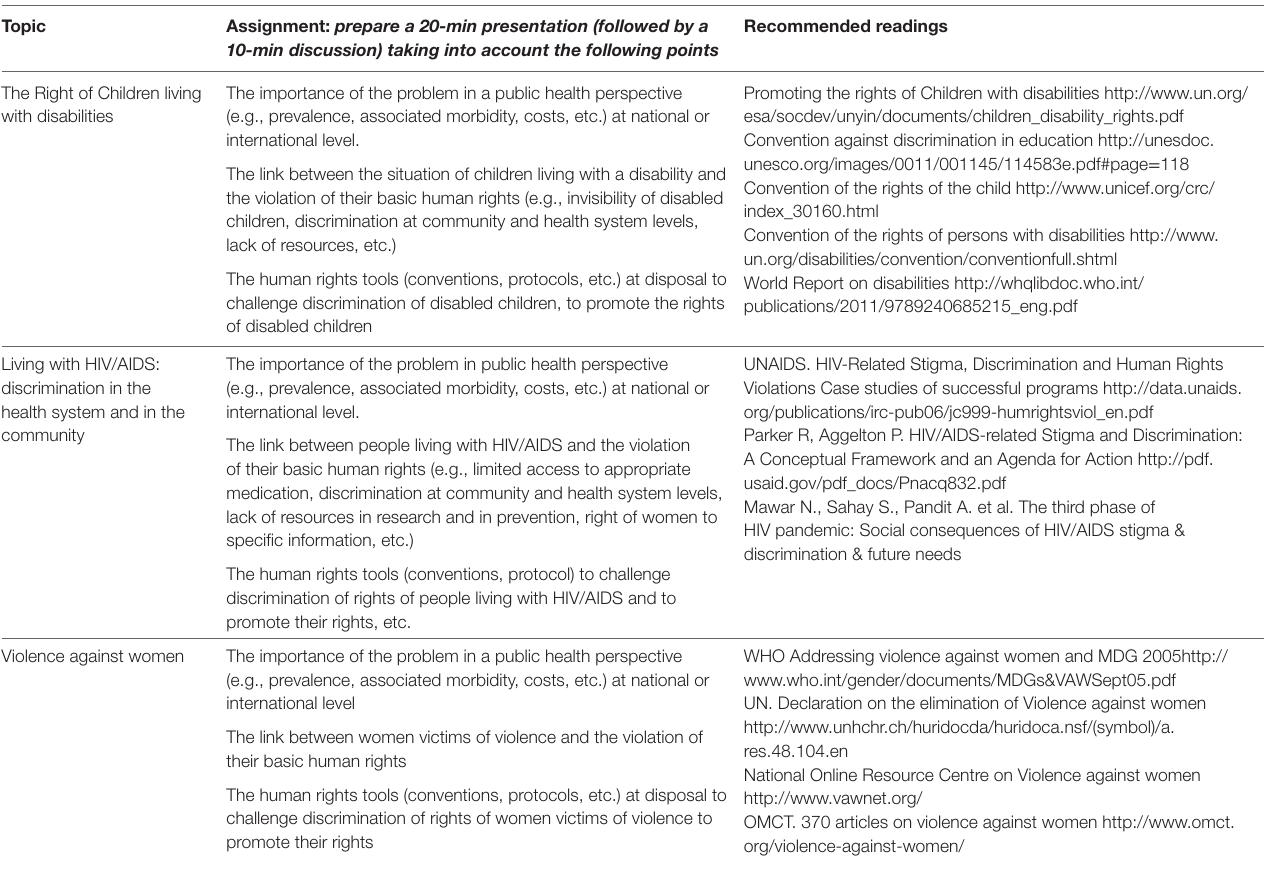
table 2 | Examples of group work topics, assignments, and recommended basic readings.